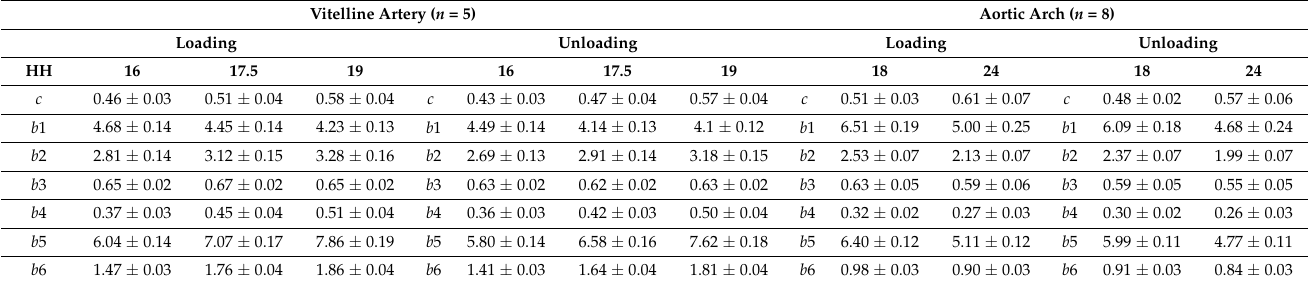
Vitelline artery: As presented in Table 3, the constant c is related to residual stress and increases with the stage of the embryo, as expected from pressure measurements and opening angle data. Constant b 1 decreases as the embryo develops, and b 3 nearly remains constant, while all other parameters ( b 2 , b 4 , b 5 , and b 6 ) increase during the growth of the recorded. These parameters were evaluated under loading and unloading conditions. For